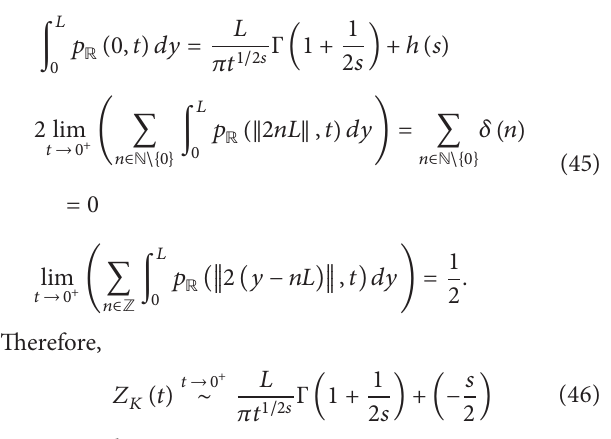
and the contribution of each term to the partition function (𝑡) = ∫ 𝑝 (𝑦, 𝑡; 𝑦)𝑑𝑦 𝑍 𝐾 𝐾 𝐾